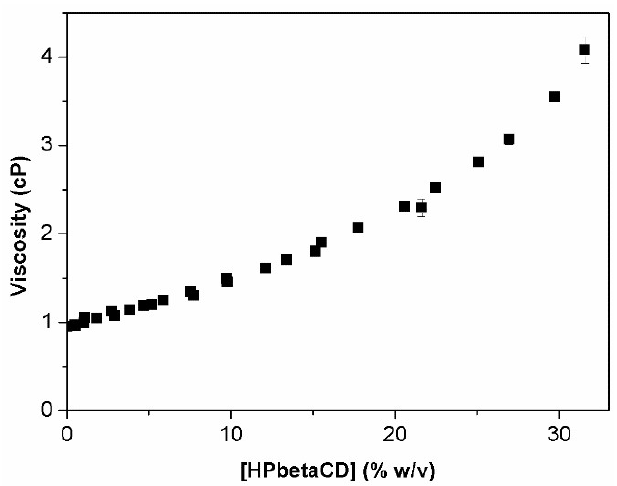
Figure 3. Increase in viscosity of pure aqueous HPβCD solutions with increasing HPβCD concentrations at 25 °C.